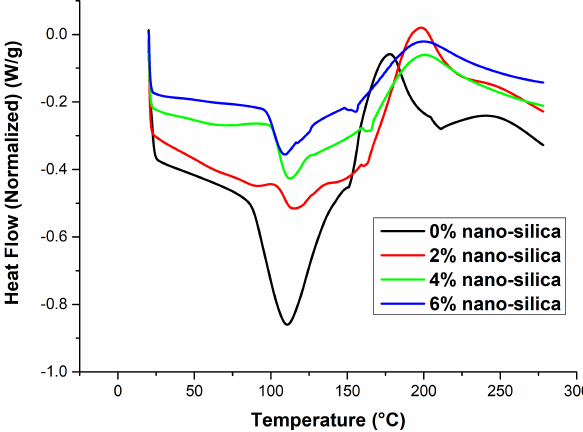
Figure 4: DSC curves of phenolic resin with nano-silica content of 0%, 2%, 4% and